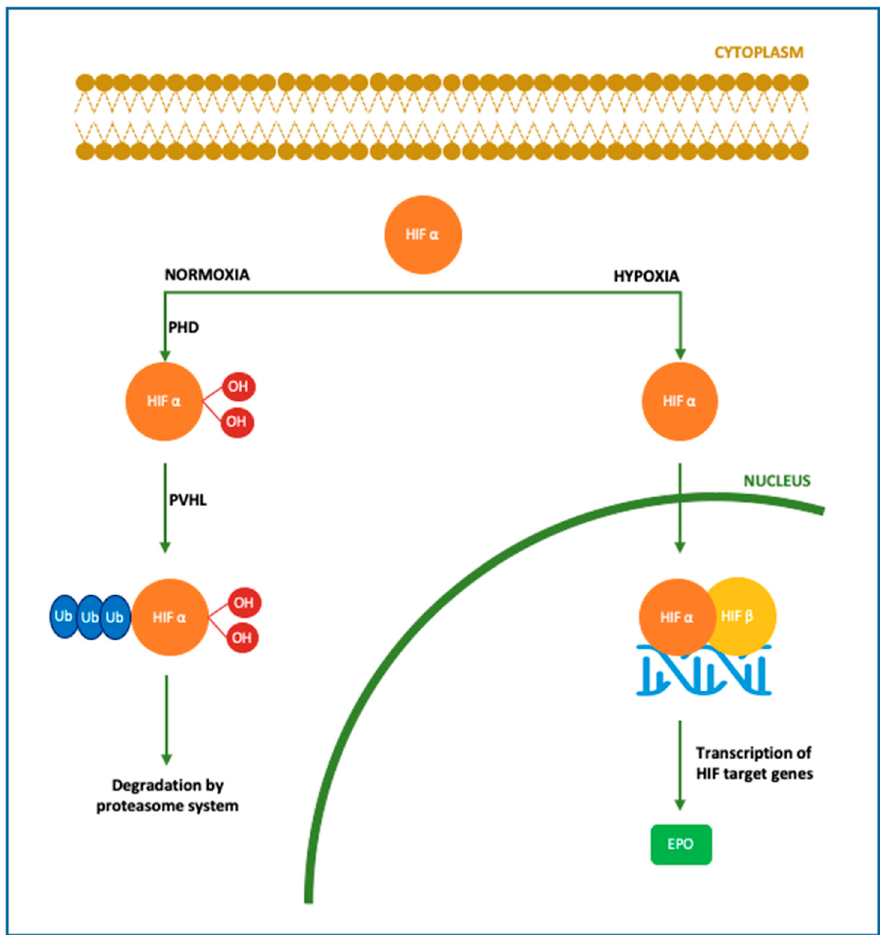
Figure 1. Molecular mechanism of Epo production. In the brain Epo production is upregulated by oxygen levels mainly in astrocytes, followed by oligodendrocytes, endothelial cells and microglia. In case of normoxia, cytoplasmic HIF α is hydroxylated and polyubiquitinated by PHD and pVHL, respectively. In this form, HIF is degraded by the proteasome system. In case of hypoxia, HIF α is dehydroxylated and deubiquinated, thus able to translocate into the nucleus and bind HIF β , inducing the transcription of its target genes among which Epo gene [70–72,97]. HIF: hypoxia-inducible factor; PHD: prolyl-4-hydroxylases; PVHL: von Hippel–Lindau protein